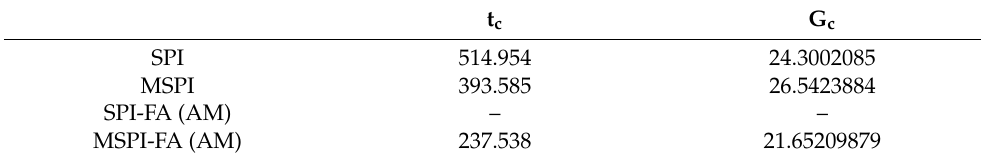
Figure 2. Time sweep ( A ) and frequency sweep ( B ) of emulsion gels induced by different modified soybean protein isolates. Table 3. Crossover points between G (cid:48) and G (cid:48)(cid:48) of different emulsion gels.